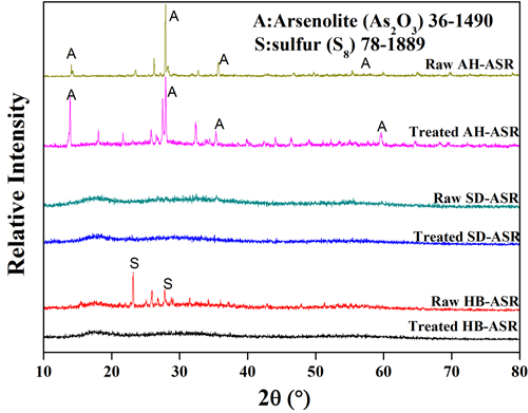
Figure 3. The XRD patterns of the raw and treated ASRs.